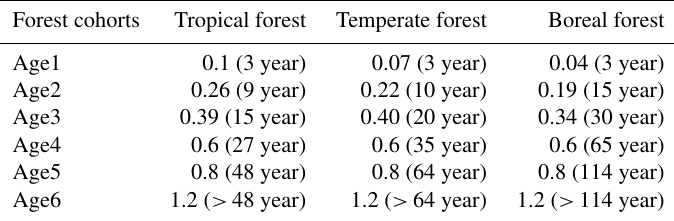
idence time of shifting cultivation assumed in LUH1.